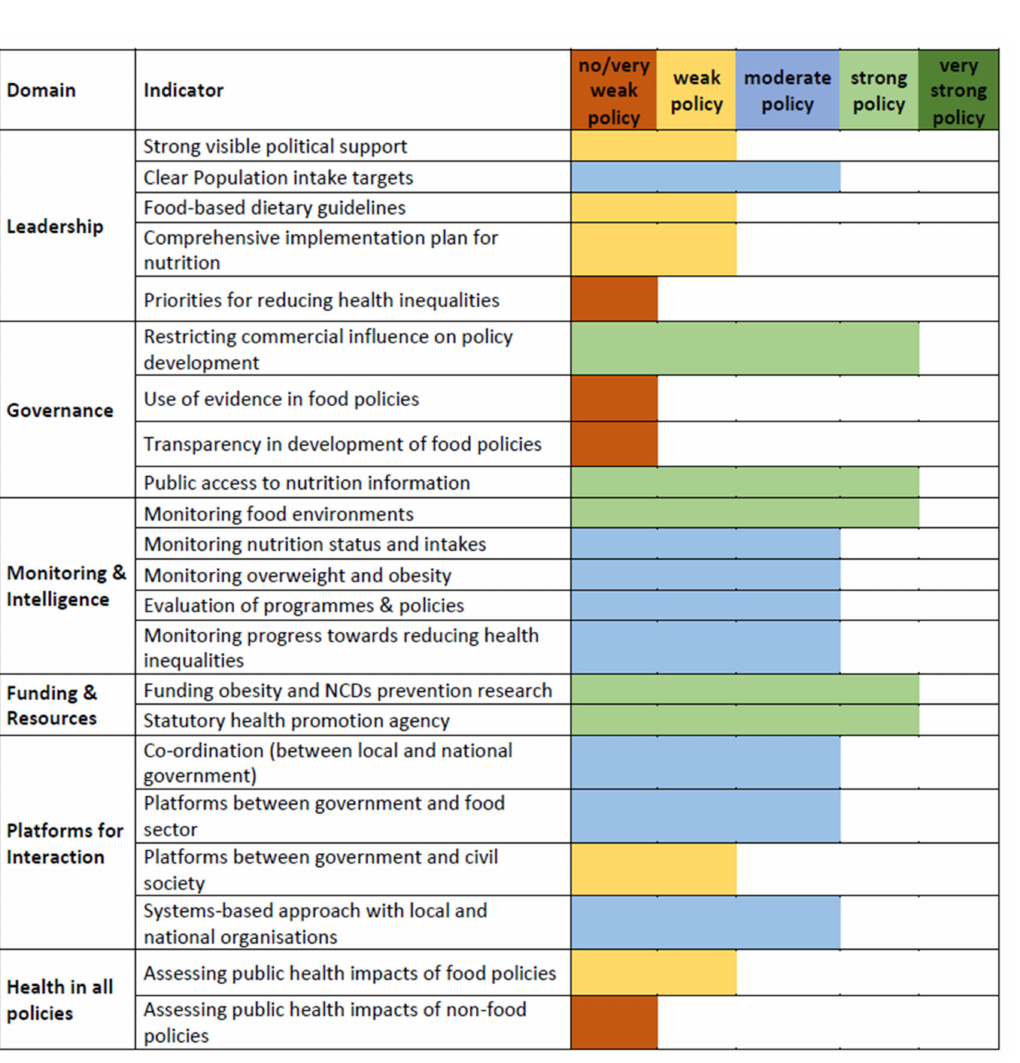
Figure 4. Results of the Food-EPI evaluation in Poland for the infrastructure-related domains and